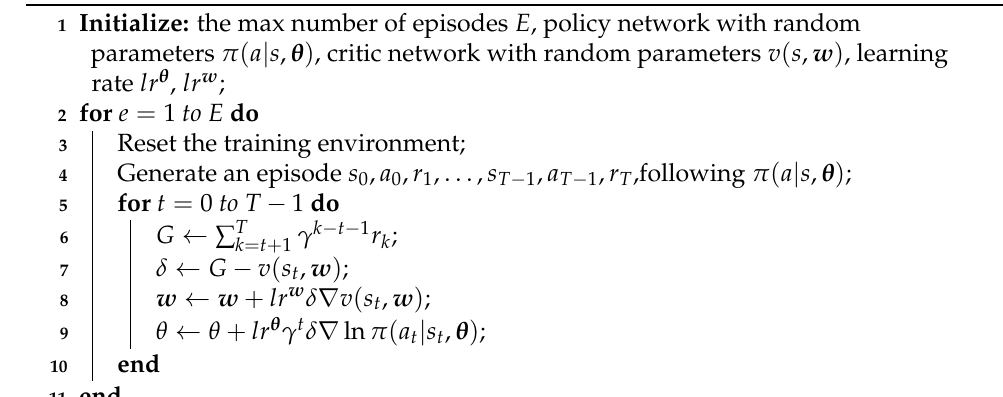
Algorithm 1: REINFORCE with critic